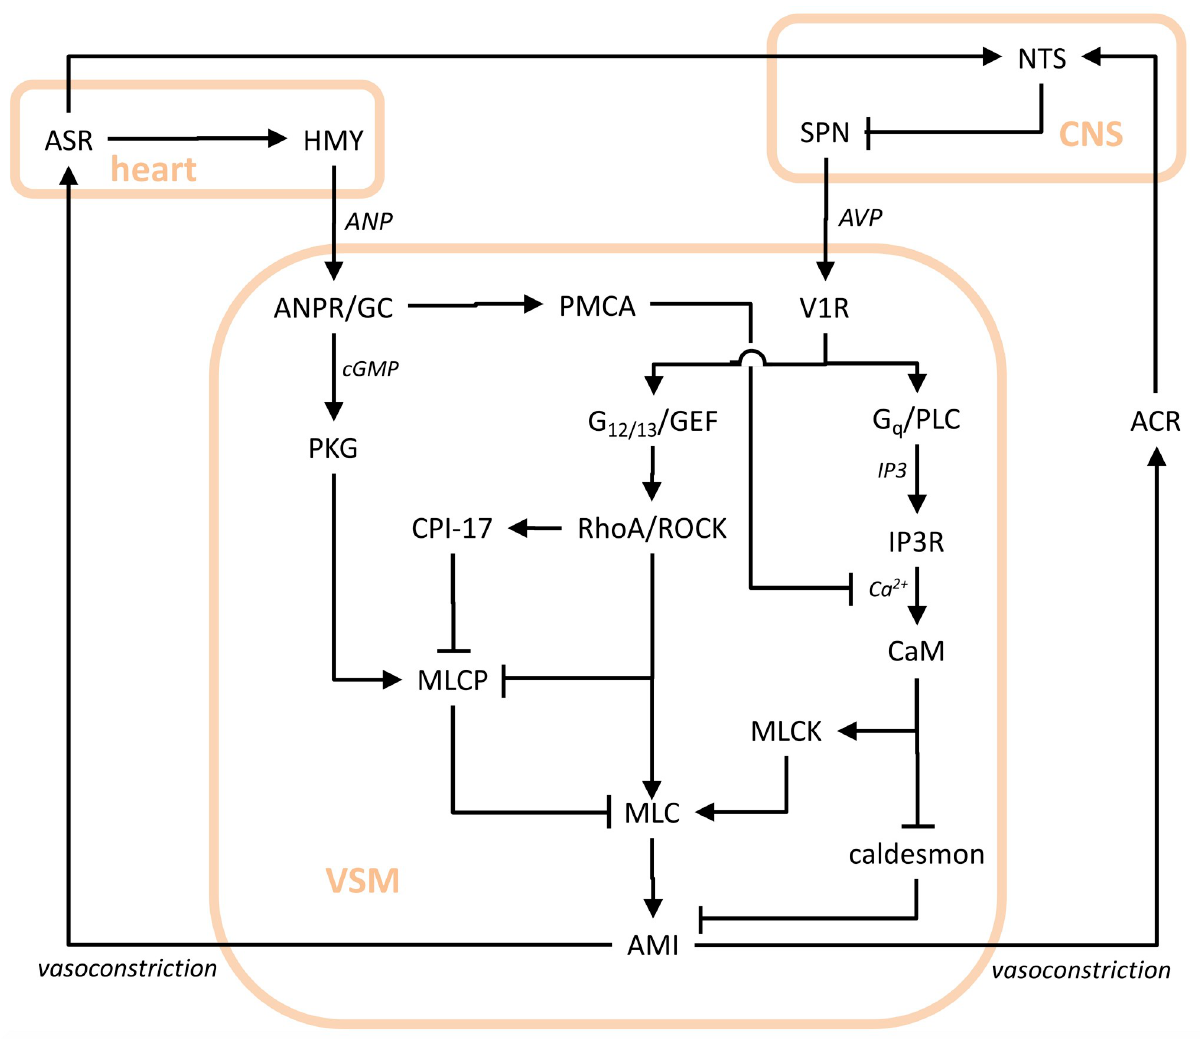
Fig 3. Diagram depicting antagonistic regulatory effects on vasoconstriction consisting of AVP and ANP endocrine systems acting on crosstalking signal transduction pathways of VSM, and stretch receptors closing the loops. Labels for functional agents are the following. AMI: actomyosin interaction; ANPR: atrial natriuretic peptide receptor; CaM: calmodulin; CPI-17: protein phosphatase 1 regulatory subunit 14A; GC: guanylate cyclase; GEF: guanine nucleotide exchange factor; G q : G q alpha subunits of heterotrimeric G proteins; G 12/13 : G 12 /G 13 alpha subunits of heterotrimeric G proteins; IP3R: inositol trisphosphate receptor; MLC myosin light chain; MLCK: myosin light chain kinase; MLCP: myosin-light- chain phosphatase; PKG: cGMP-dependent protein kinase; PLC: phospholipase C; PMCA: plasmamembrane Ca 2+ -ATPase; RhoA: Ras homolog gene family member A small GTPase; ROCK: Rho-associated protein kinase; V1R vasopressin receptor 1. Labels for effect mediators and anatomical districts are the following. cGMP: cyclic guanosine monophosphate; IP3: inositol trisphosphate. Other labels and line endings as in Fig 1.